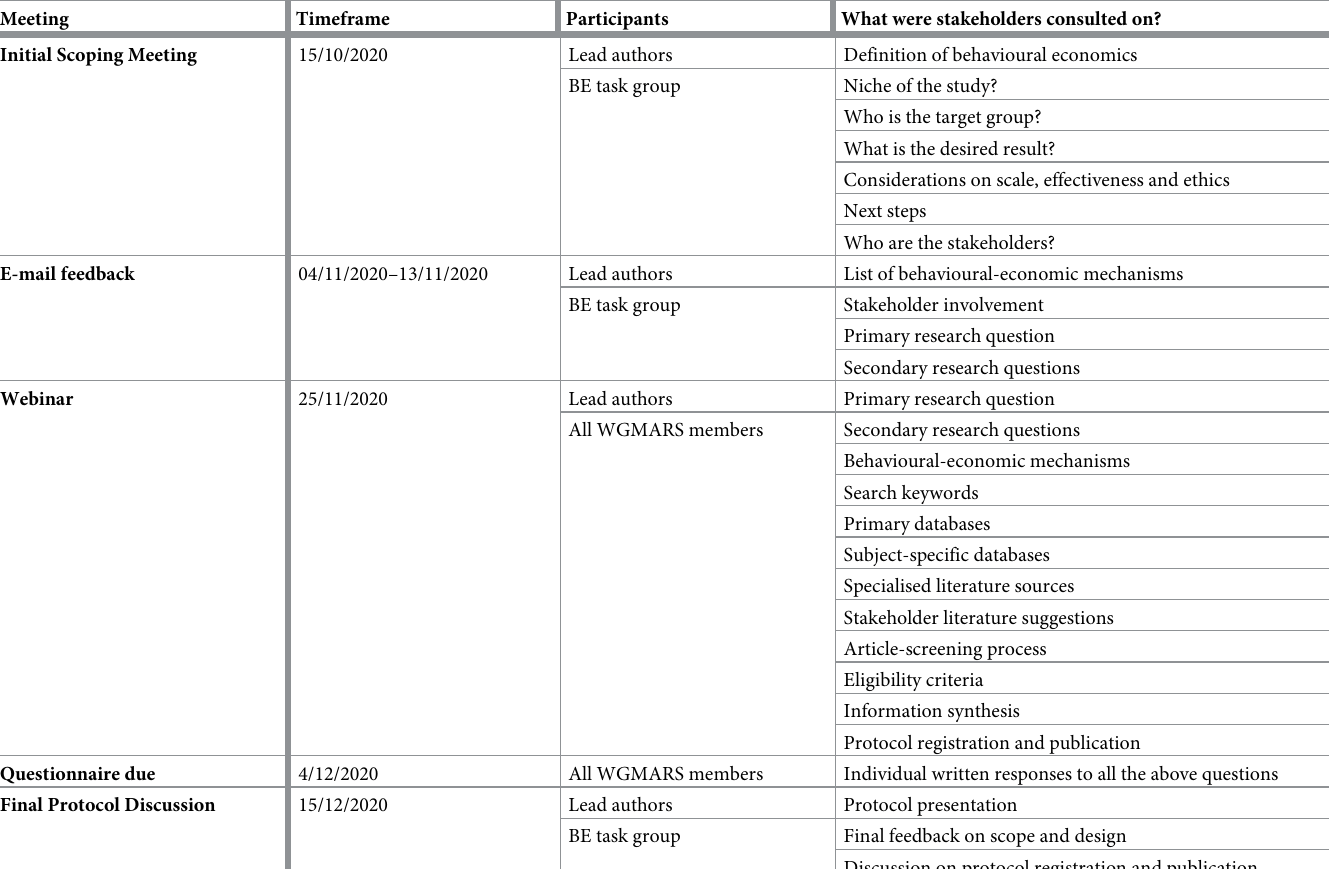
Table 1. Timeline of stakeholder consultation for the development of this